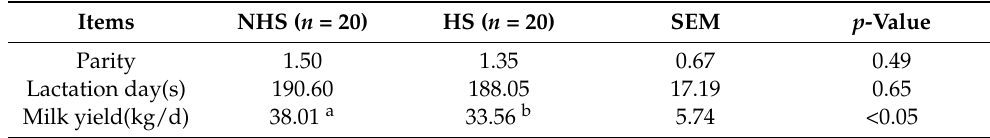
Table 1. Characteristics of the Holstein dairy cows used in the study. Items